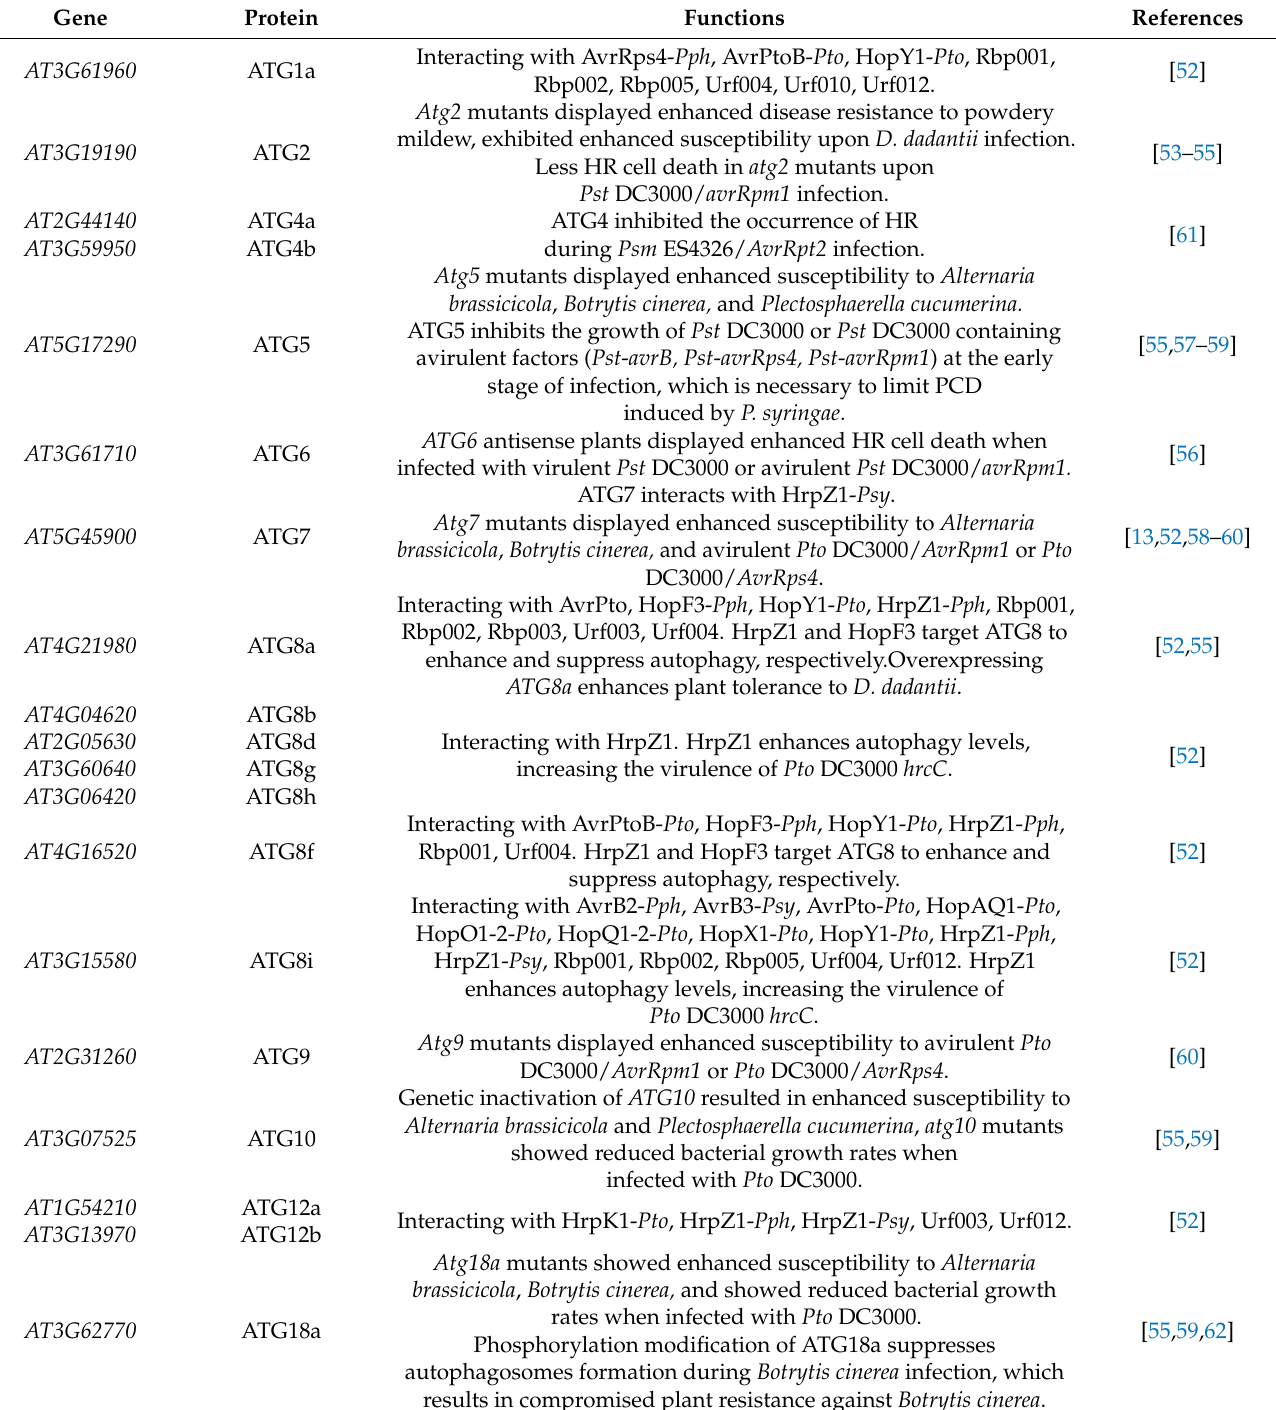
Table 1. ATGs (autophagy-related genes) in Arabidopsis participate in plant disease resistance. Gene Protein